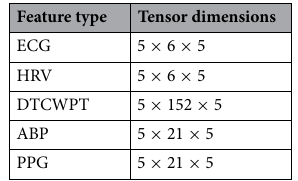
Table 2. Tensors formed for each feature